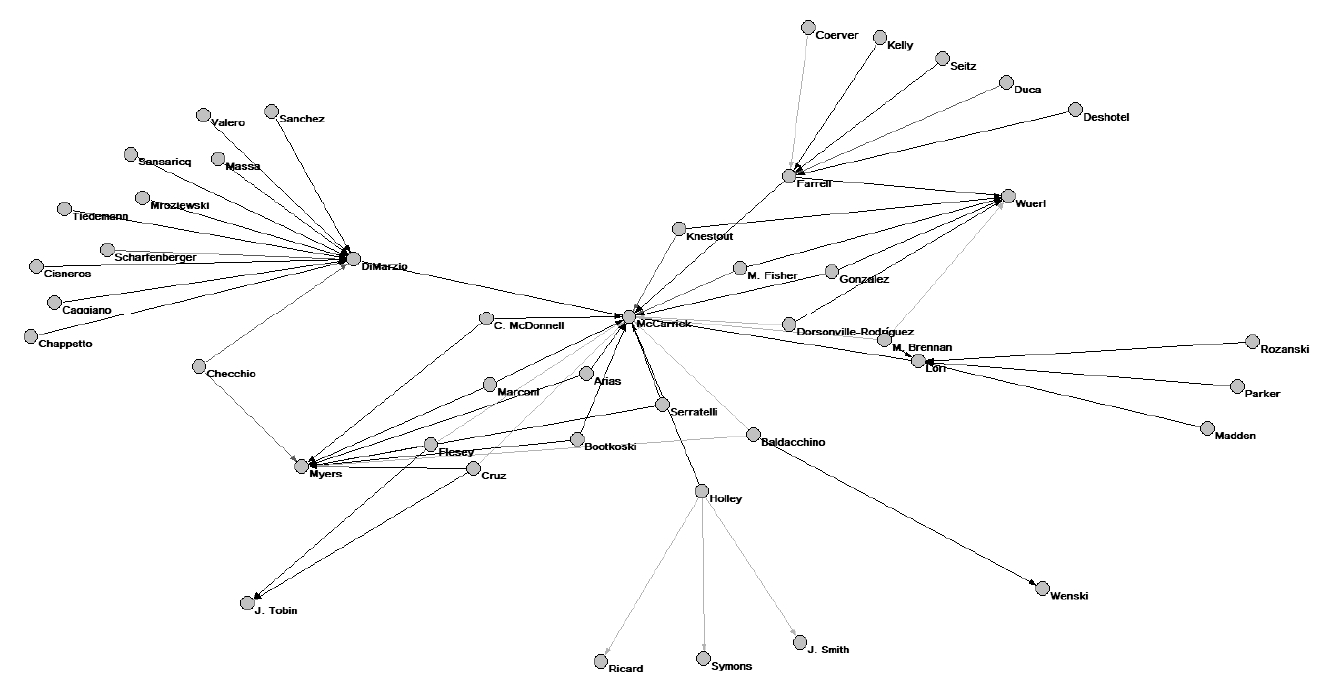
Figure 4. Ego-network for McCarrick, showing two degrees of separation (July 2018).